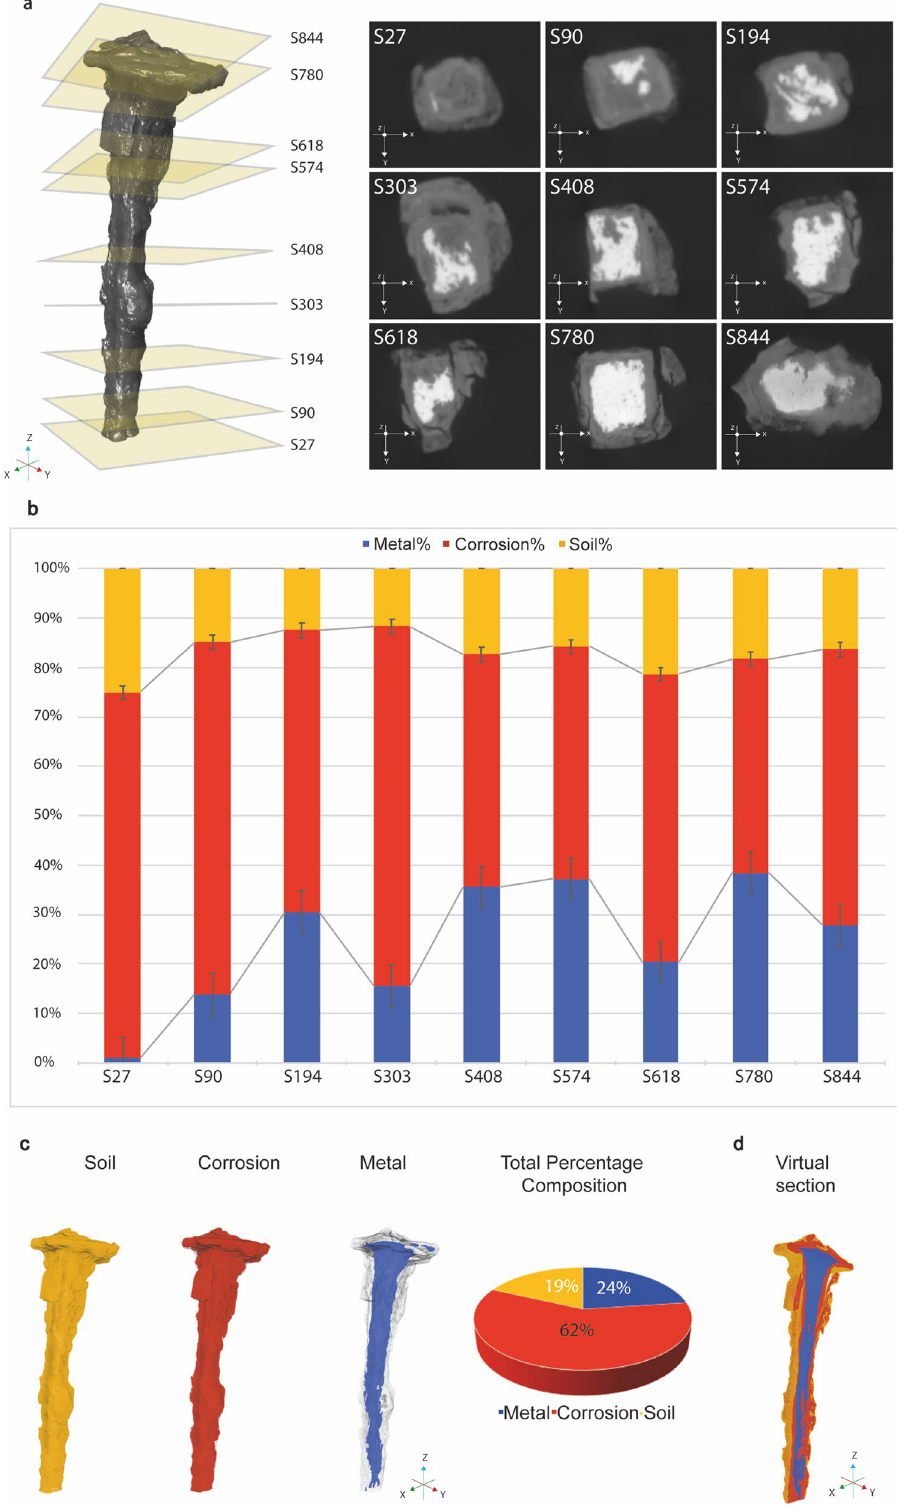
Figure 3. Low-resolution scans and 3D reconstruction of the nail. ( a ) On the left, the exact position of each virtual cross section in the nail shown on the right. ( b ) Histogram quantifying percentages of metal, corrosion and soil per each slice shown in a. ( c ) 3D reconstruction of the nail and segmentation of different layers: yellow—soil, red—corrosion layer, blue—metal; on the right, pie chart indicating the total percentages composition resulted by imaging segmentation. ( d ) Sagittal section of the 3D reconstruction showing the internal region of one half of the